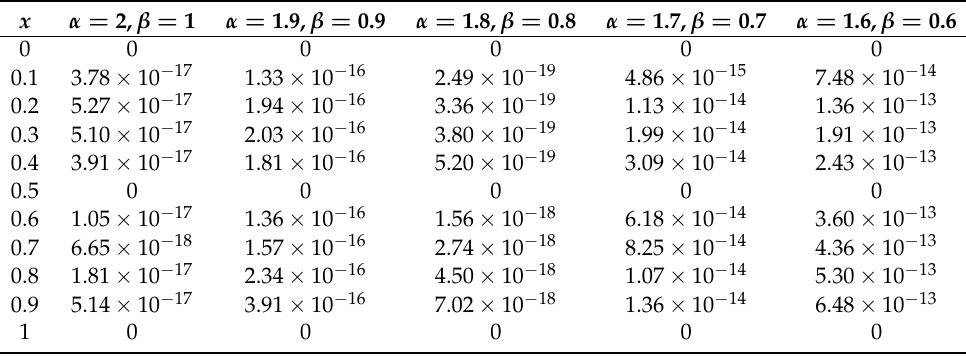
Table 2. Comparison of absolute error of Example 1 for various α , β ( m = 3, n = 5).